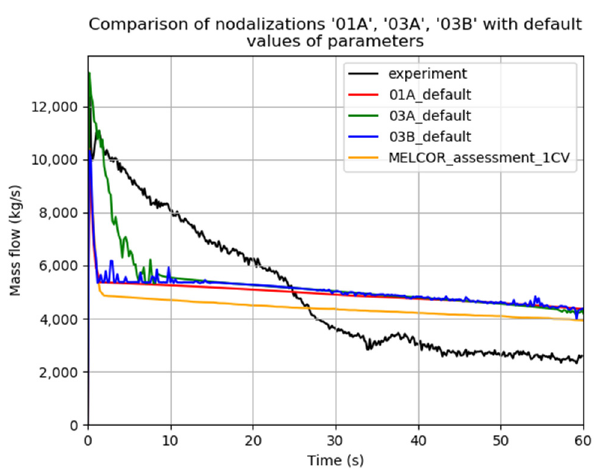
Figure 3. Mass flow rate for the models with 1 CV and 3 CV 01A, 03A, and 03B nodalizations compared with the experimental data and MELCOR results taken from reference [12].